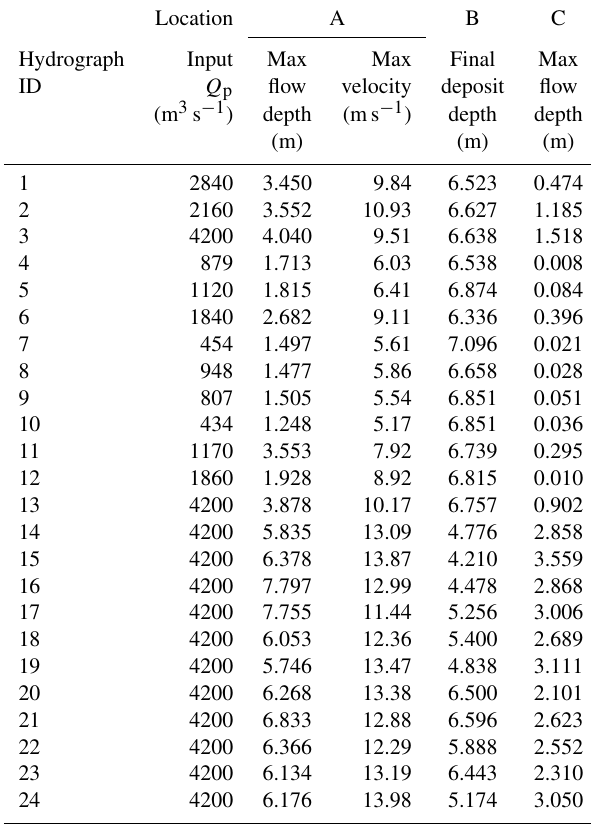
Table A3. Summary of outputs for the Currie D simulations using f = 0 . 13, ξ = 100ms − 2 .